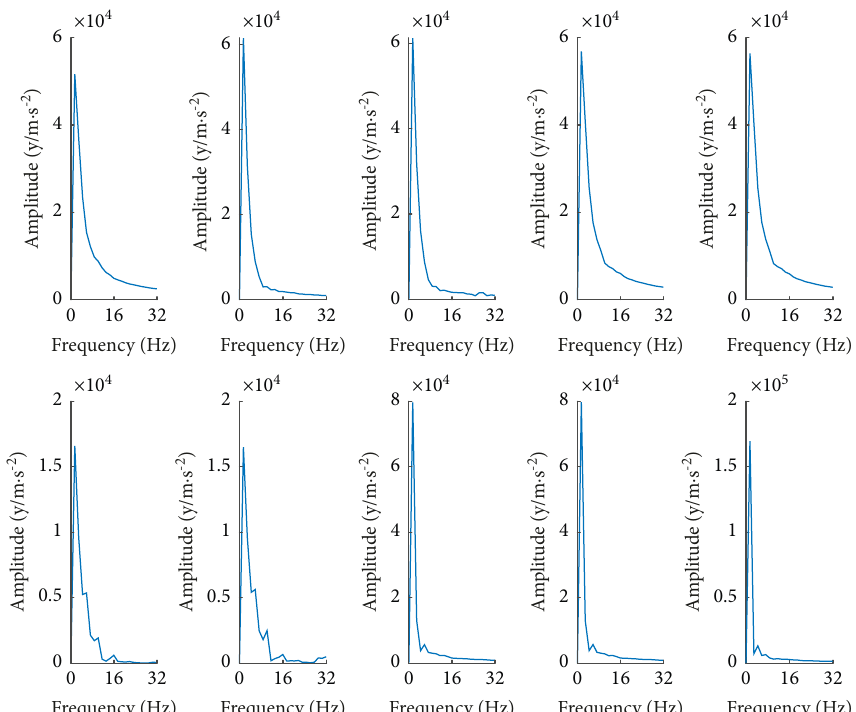
Figure 18: Vertical displacement frequency spectrum of each measuring point of the